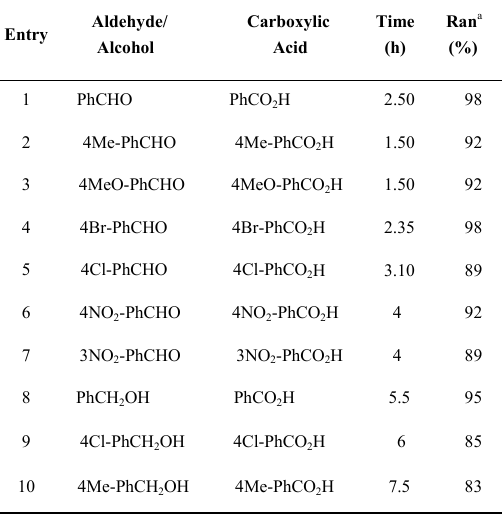
Table 1. Oxidation of aldehyde/alcohol O nanoparticles with Cr 2 3